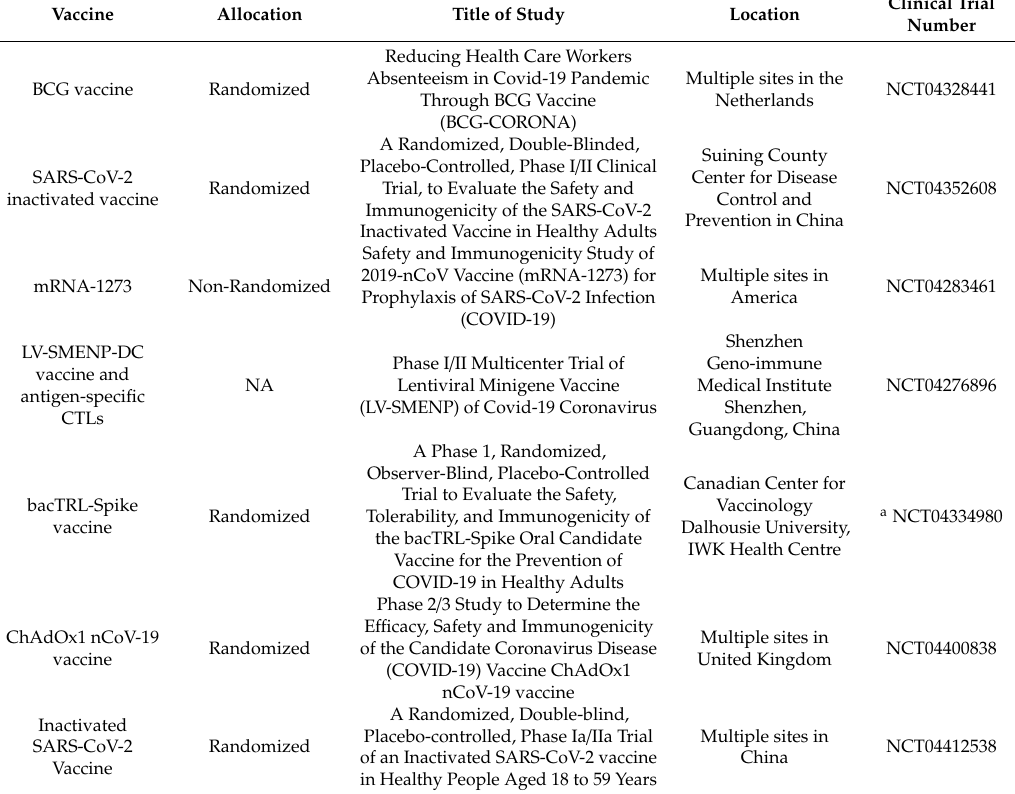
Table 6. Development of vaccines for COVID-19 that are under clinical